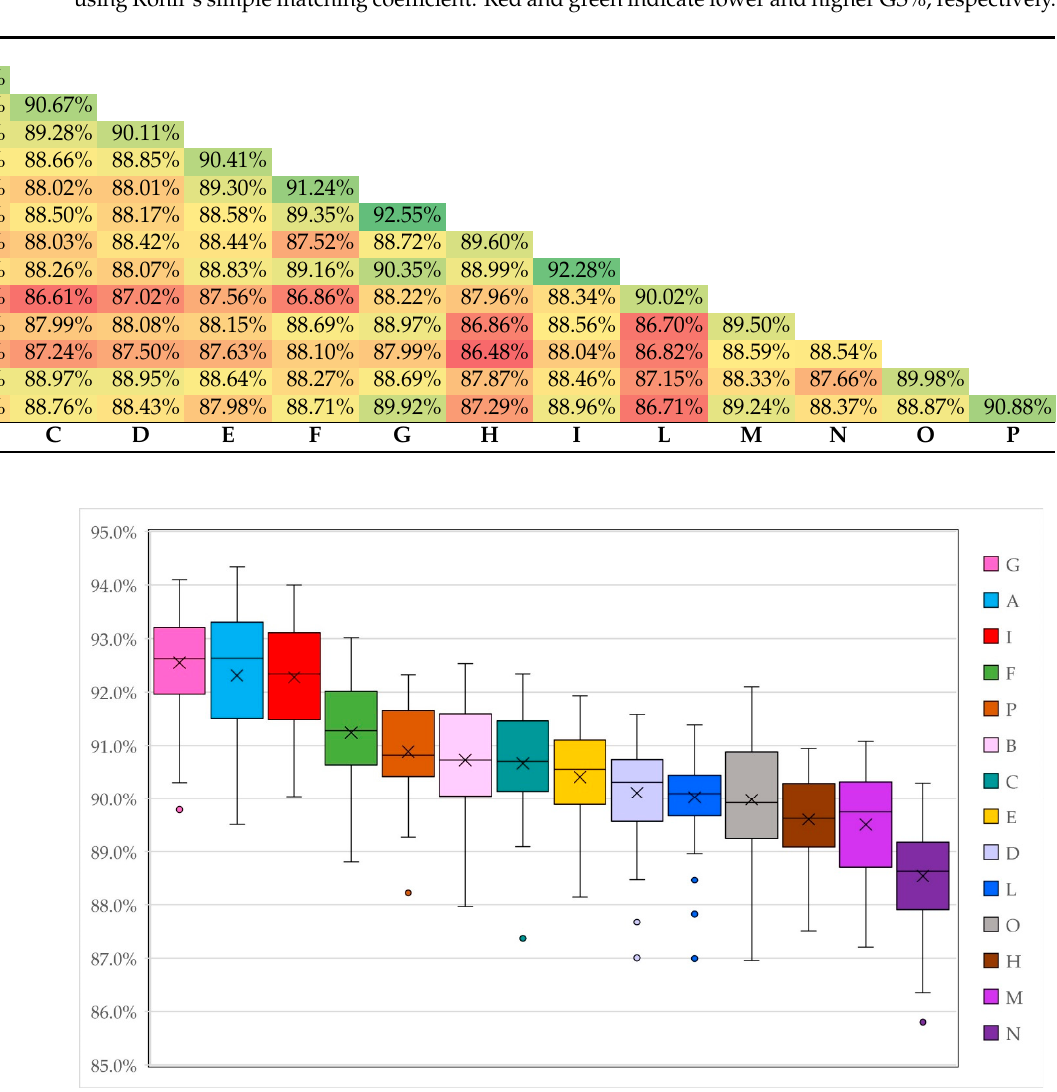
Figure 1. Box plot of mean GS within each variety in descending order. The second and third quartiles are marked inside the square and are divided by a bar (median). The cross (×) within each box represents the mean value. Dots show outlier samples. Different letters and colors refer to the different varieties examined In addition, an analysis of molecular variance (AMOVA) was conducted to better understand the distribution of genetic differentiation among and within varieties of Ital- ian ryegrass. Findings from AMOVA revealed that 87% (resulting from the sum of 60% found within all the individuals and 27% found among the individuals nested in popula- tions) of the total genetic variation was contributed by differences within varieties, which